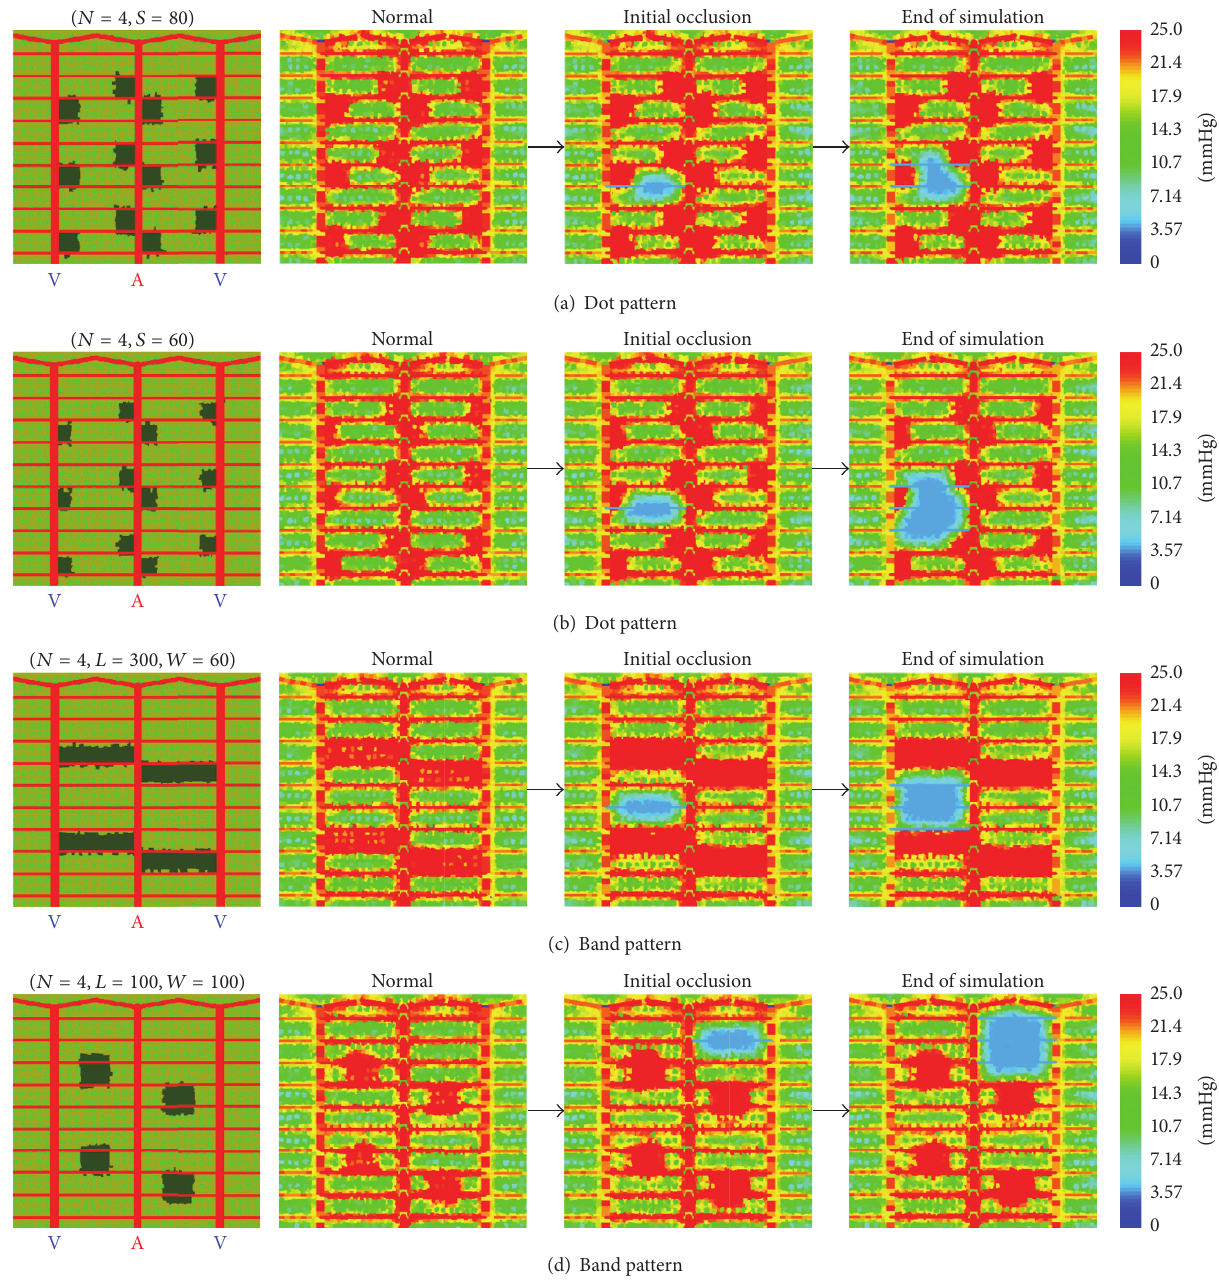
Figure 4: Dot and band burn patterns: effects of size. Size effects of dot and band pattern laser burns on ischemic progression. Dot pattern burns (first subfigure rows (a) and (b)) with 𝑆 = 80 microns (a) and 𝑆 = 60 microns (b) and their effectiveness on prevention of ischemic progression (second to fourth subfigures rows (a) and (b)). Label 𝑁 = 4 indicates that the initial total photocoagulated area of these dot pattern burns is equivalent to that with 𝑁 = 4 band pattern burns. Dot pattern burn is 40 microns. Band pattern burns (first subfigure rows (c) and (d)) with “ 𝐿 = 300 microns, 𝑊 = 60 microns” (c) and “ 𝐿 = 100 microns, 𝑊 = 100 microns” (d) and their effectiveness on prevention of ischemic progression (second to fourth subfigures rows (c) and (d)). Label 𝑁 = 4 means that the number of laser burns is 4. Color bar for oxygen maps has unit mmHg. Warmer color in oxygen maps represents higher oxygen